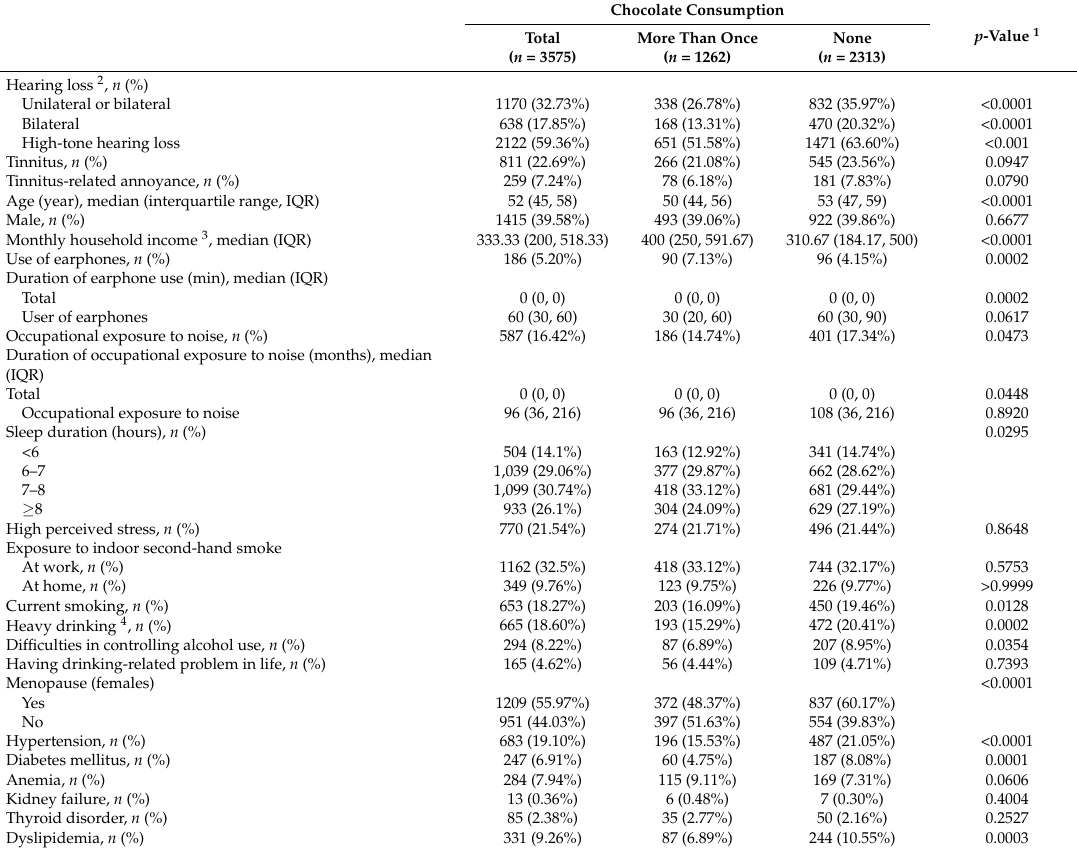
Table 1. Characteristics of the 40–64-year-old subjects according to chocolate